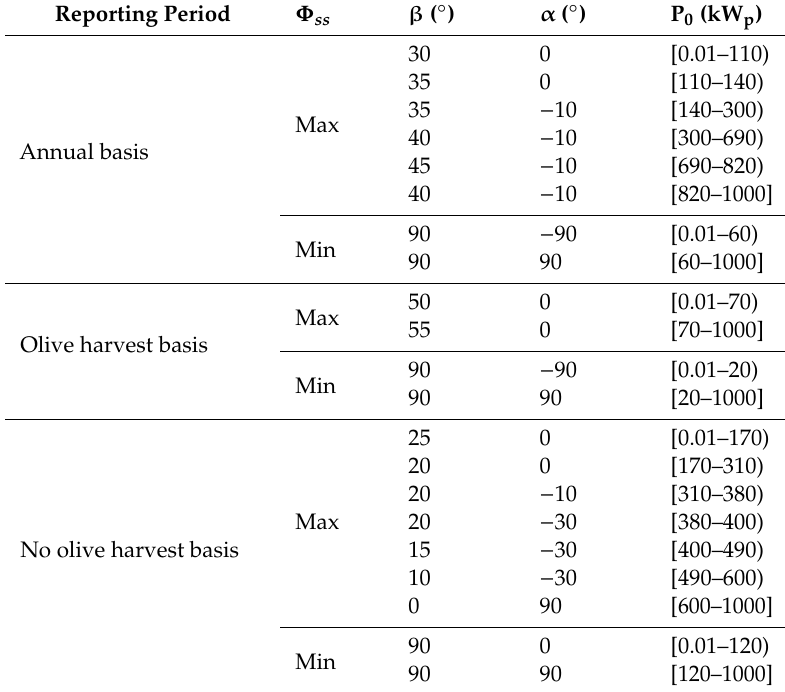
Table 4. Maximum and minimum self-su ffi ciency indices as a function of P 0